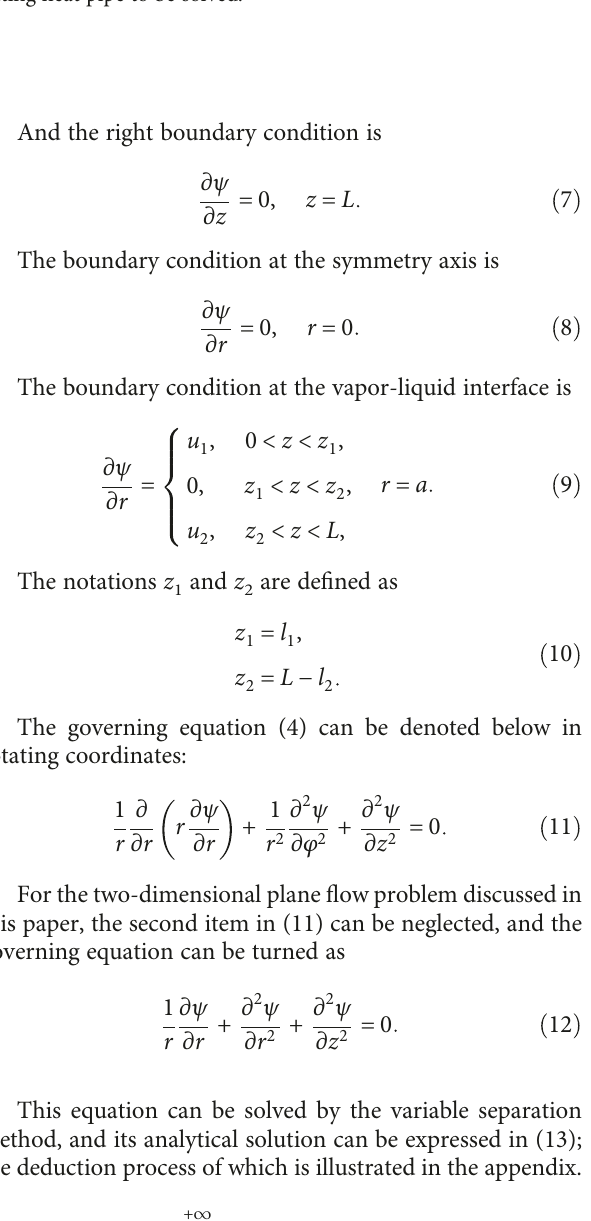
Figure 1: Physical model of the rotating heat pipe to be